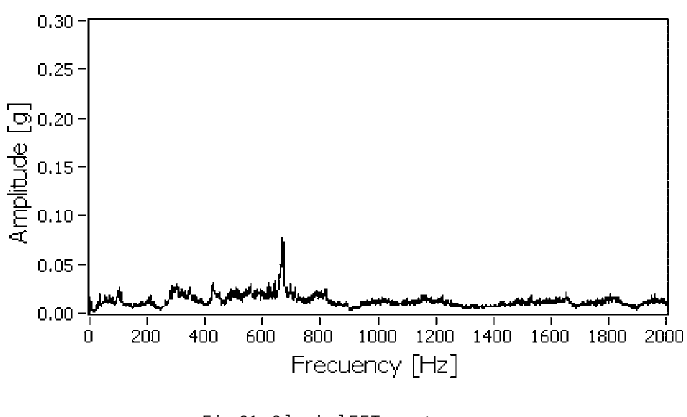
Fig. 21. Classical FFT